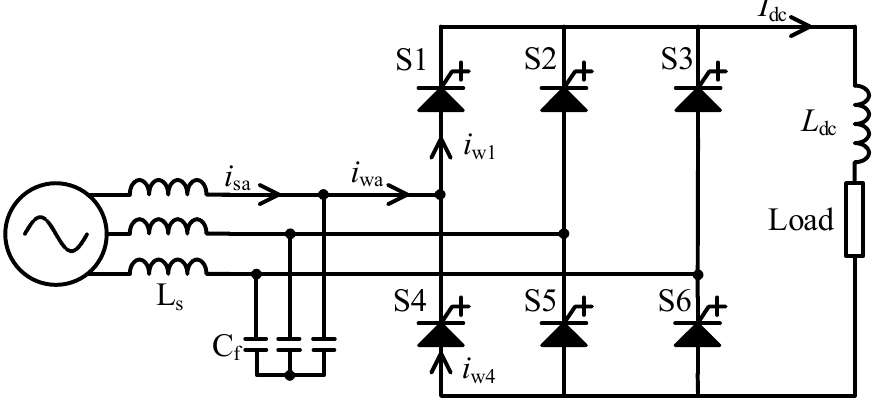
Figure 1. The topology of the current source rectifier.